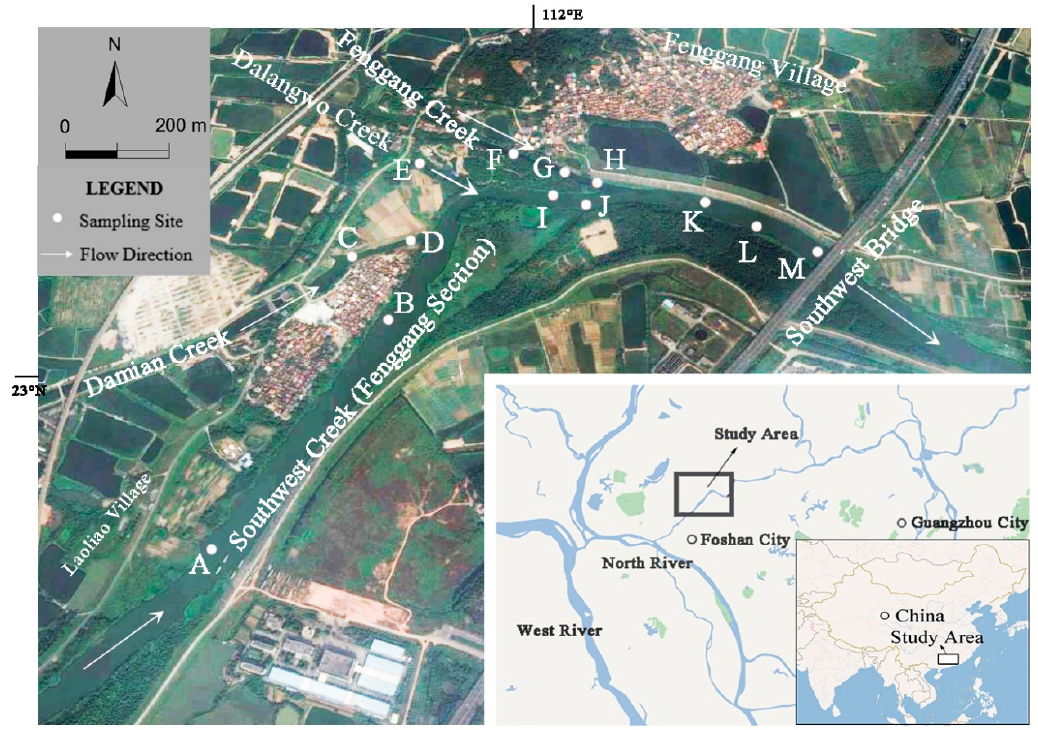
Figure 1. Map of investigation site for sediments sampling. 23° N and 112° E are labelled, and arrows indicate the flow direction of water.